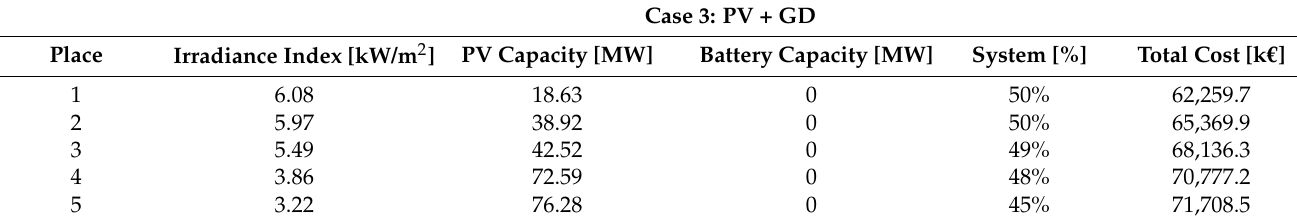
Table 4. Summary of total costs—third